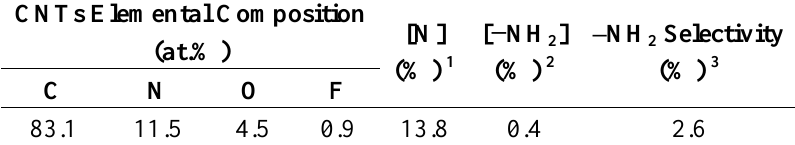
Table 2. XPS analysis of treated CNT pellet: relative content in [N] and [NH